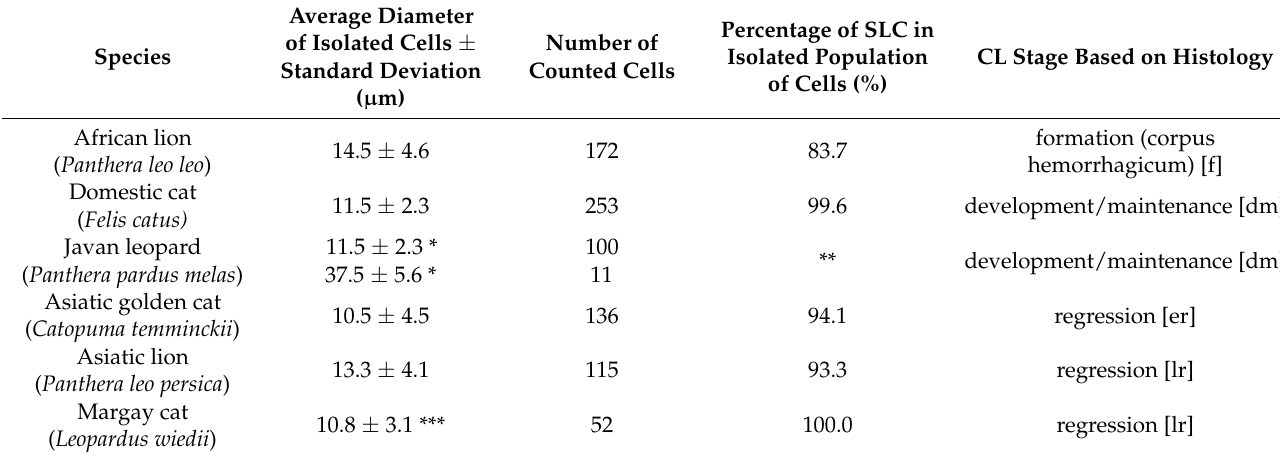
Table 3. Information about the population of isolated